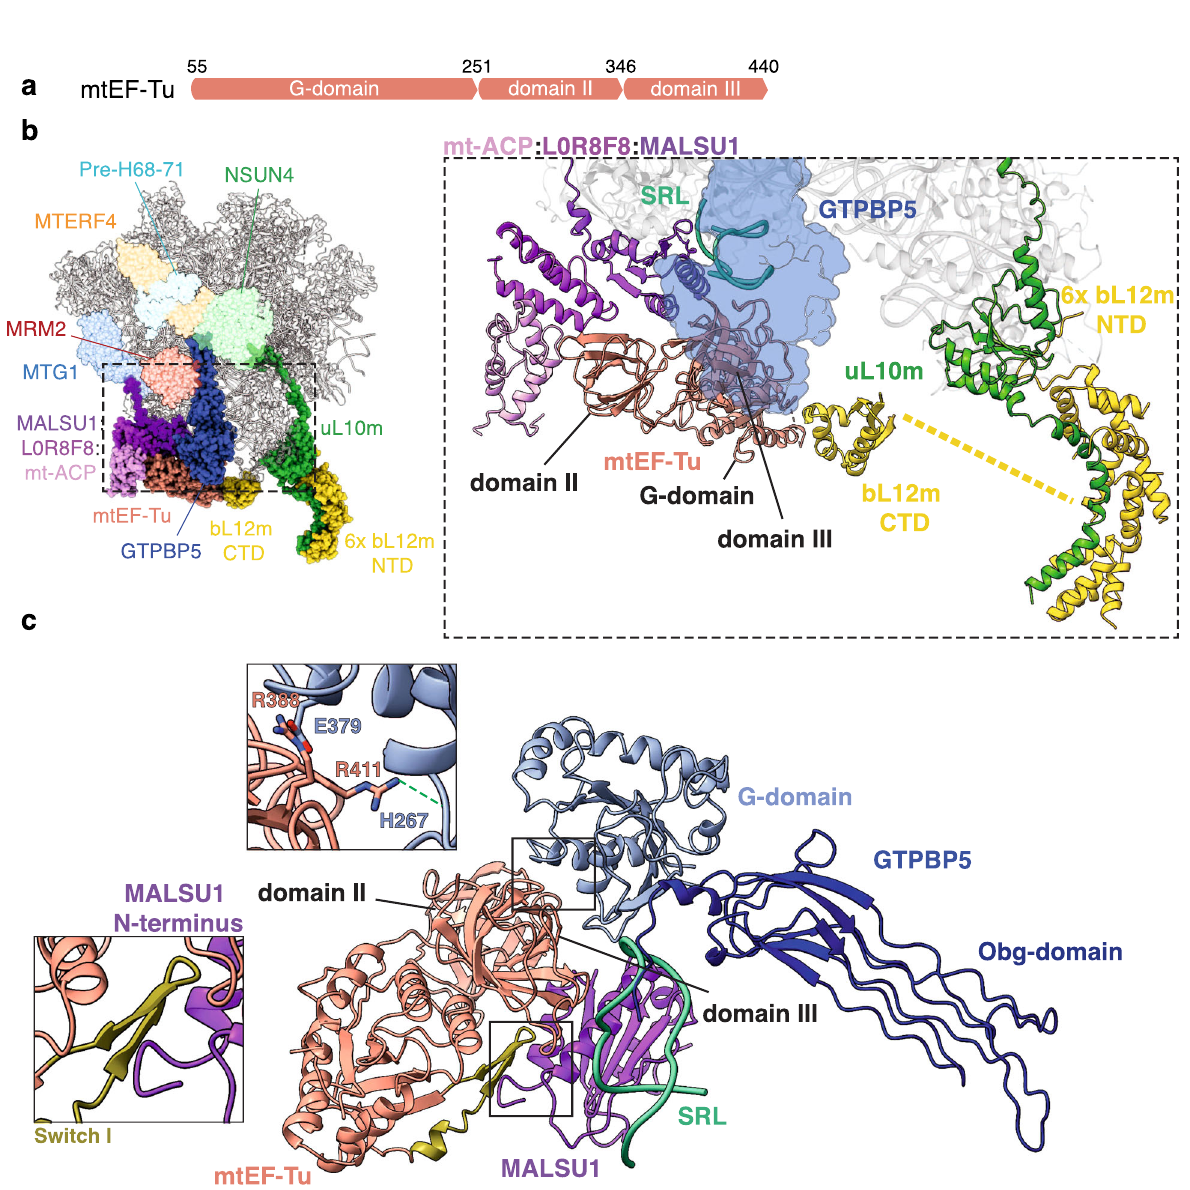
Fig. 4 Interaction of mtEF-Tu with the mt-LSU assembly intermediate. a Schematic representation of mtEF-Tu domains. b Overview of mtEF-Tu interaction with GTPBP5, the MALSU1 module, and the bL12m C-terminal domain (left panel) and corresponding zoom-in panel (right panel). mtEF-Tu G- domain, domain II and domain III and the SRL are indicated. The six copies of bL12m N-terminal domain 29,30 and uL10m are also highlighted. The yellow dashed line indicates a hypothetical connection between bL12m CTD and one of the six copies of bL12m NTD, not visible in the structure. c Representation of the mtEF-Tu interaction with GTPBP5 and MALSU1. The upper zoomed-in panel features interactions between the GTPBP5 G-domain and the mtEF-Tu domain III. The green dashed line indicates interactions to the RNA phosphate backbone. The lower zoom-in panel shows the mtEF-Tu switch I interaction with